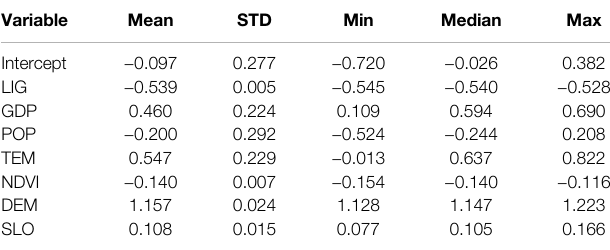
TABLE 6 | Statistical description of the MGWR coef fi cient of CS services. Variable